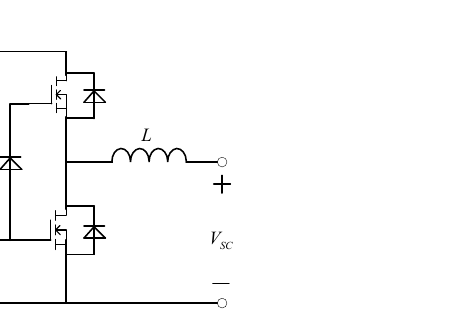
Figure 9. 2-Quadrant DC/DC buck-boost transformer for the supercapacitor.